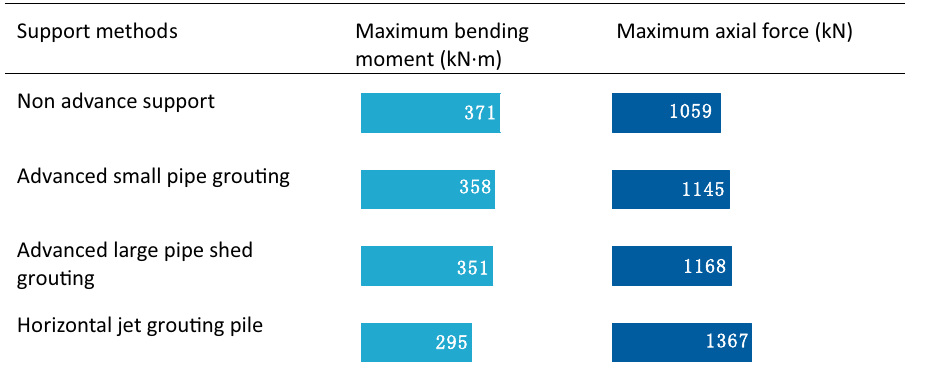
Table 10. Internal force of primary support at different support methods.